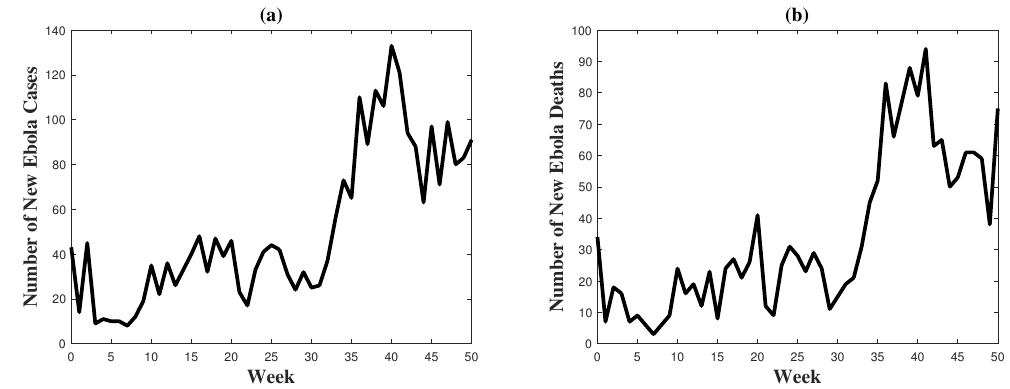
Fig. 2: Democratic Republic of Congo plots for (a) new Ebola cases (b) new Ebola